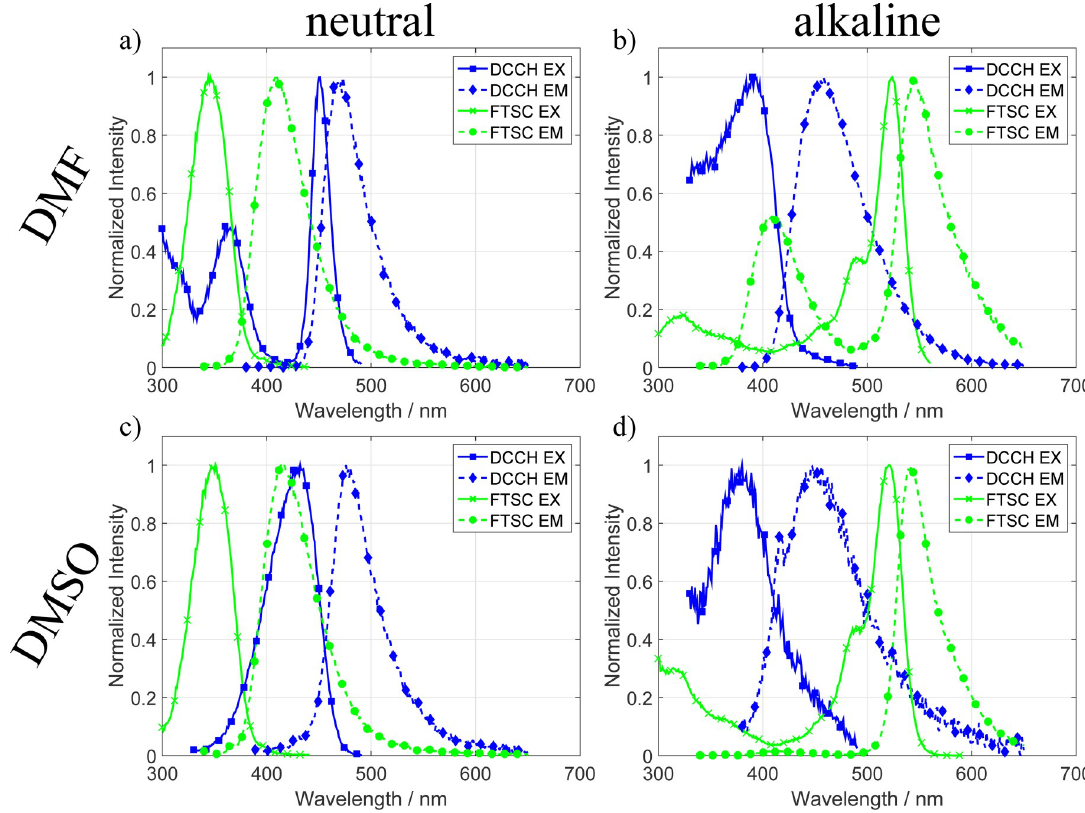
Fig 4. Normalized excitation and emission spectra of DCCH and FTSC in different solvents and pH values. In a) and b) one can see the spectra in DMF. Here the FTSC EX/EM shifts to 340/410 nm in the neutral case and shifts back to higher wavelengths (520/540 nm) in alkaline conditions where it additionally exhibits a second emission at 410 nm. The DCCH main excitation becomes narrower and a second excitation at 370 nm appears in the neutral state. Going to alkaline conditions shifts the DCCH spectra into the blue. c) and d) show the spectra in DMSO. The spectra for FTSC look quite similar as in DMF with the exception of the missing additional emission at 410 nm in the alkaline state. The DCCH spectra for the alkaline conditions are similar while in the neutral state the excitation spectrum shifts a few nm into the blue and the spectra become wider.